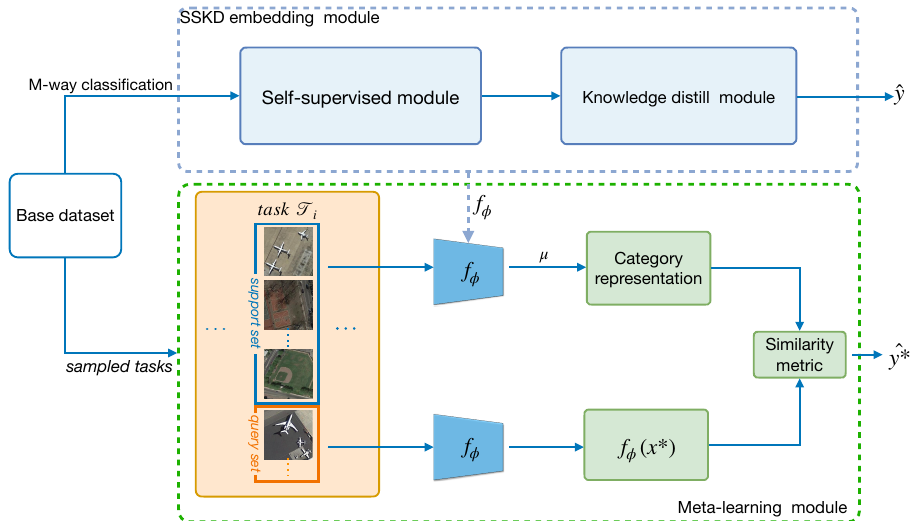
Figure 3. Overall framework of the proposed method. It contains two modules: the SSKD module aims at learning a powerful embedding, without any additional annotation effort that offers more discriminative representations to the downstream meta-learner. The meta-learning module is based on ProtoNets with an additional parameter γ to scale cosine